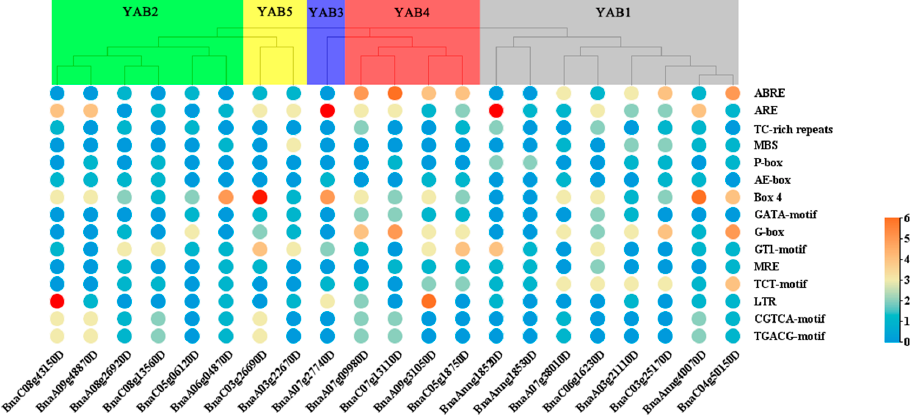
Figure 5. Analysis of major cis -acting elements in BnaYAB promoters. The number of cis -regulatory elements is indicated as a heatmap (Table S1).